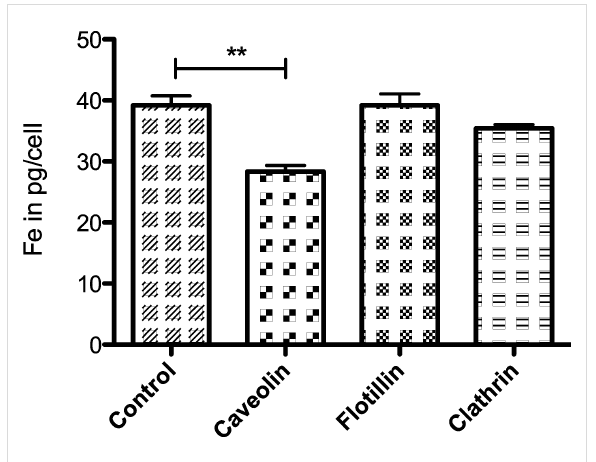
Figure 4: Iron content of control and transfected HeLa cells in pg/cell after 24 h incubation with unmodified SPIONs; target